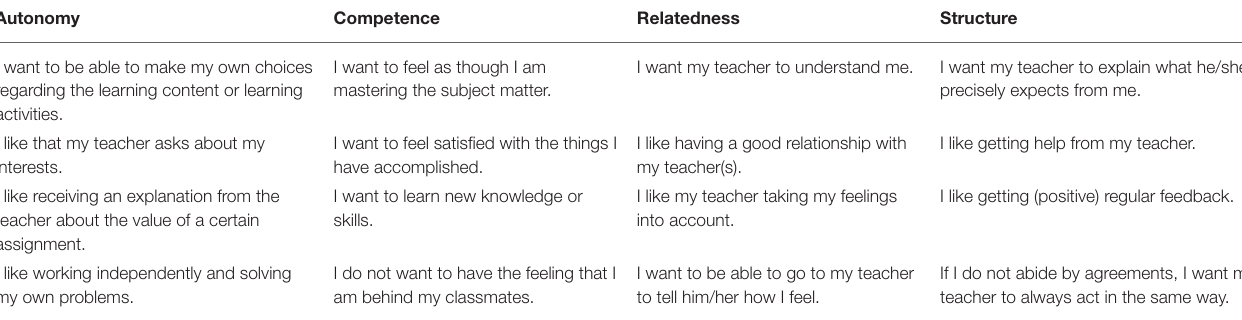
TABLE 2 | Items of need support, arranged by increasing level of importance. Autonomy Competence